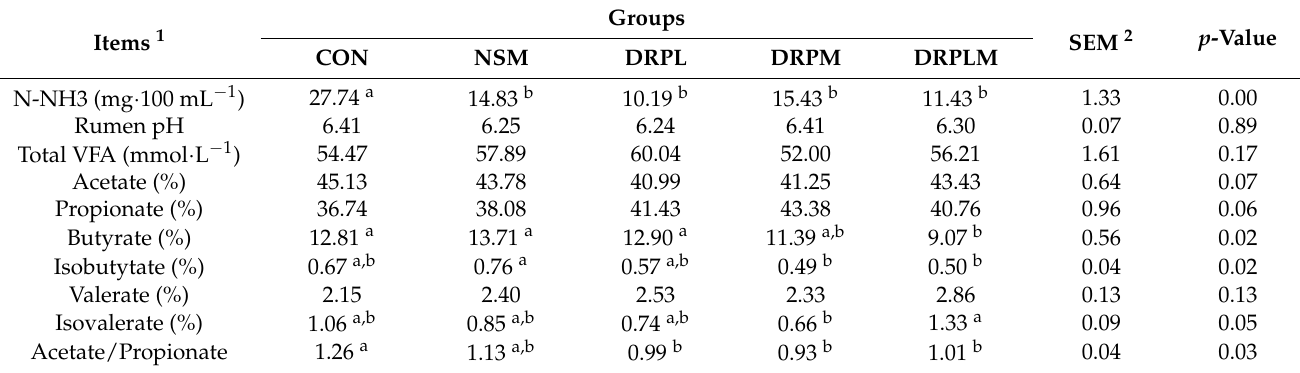
Table 5. Effects of dietary supplementation with rumen-protective amino acids on the rumen fermentation parameters of Hu